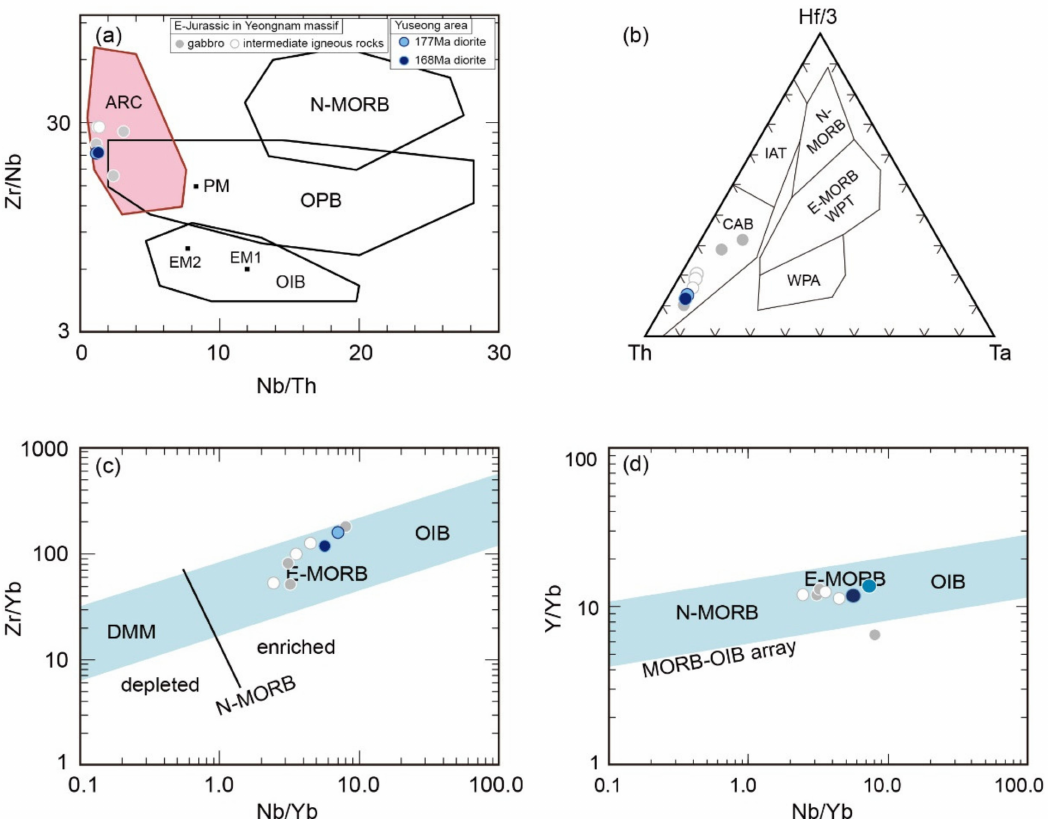
Figure 4. Variation plots for the Middle Jurassic diorite in the Yuseong area and the Early Jurassic gabbro and intermediate igneous rocks in the YM in the ( a ) Zr/Nb vs. Nb/Th (after Condie [27]), ( b ) Hf/3-Th-Ta (after Wood [37]), ( c ) Zr/Yb vs. Nb/Yb, and ( d ) Y/Yb vs. Nb/Yb (after Green [38]) diagrams. ARC: arc related basalt; PM: primitive mantle; OPB: ocean plateau basalt; N-MORB: normal mid-oceanic ridge basalt; EM1: enriched mantle 1; EM2: enriched mantle 2; OIB: ocean island basalt; CAB: calc-alkaline basalt; IAT: island-arc tholeiite; E-MORB: enriched mid-oceanic ridge basalt; WPT: within-plate tholeiite; WPA: within-plate alkaline basalt; DMM: depleted MORB